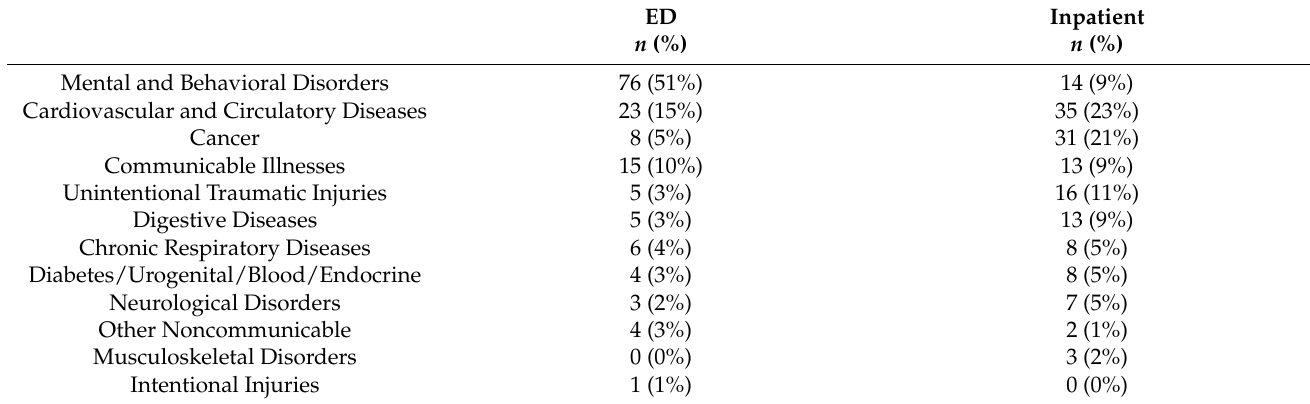
Table 2. Primary Illness Categories Identified for ED and Inpatient LLOS Encounters.